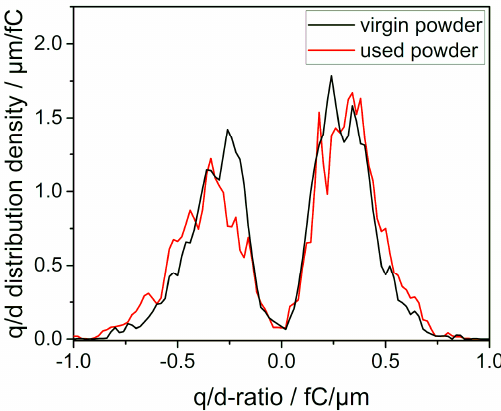
Figure 4. Charge-to-diameter distributions of virgin and used PA12 laser sintering powder obtained by charge spectrometry measurements. Shown values are averaged over three measurements. Table 2. Mean q/d values for positive and negative charged particles and share of positive polarity particles obtained by q/d-meter measurement of virgin and aged PA12. Values in brackets represent the standard deviation over three measurements.